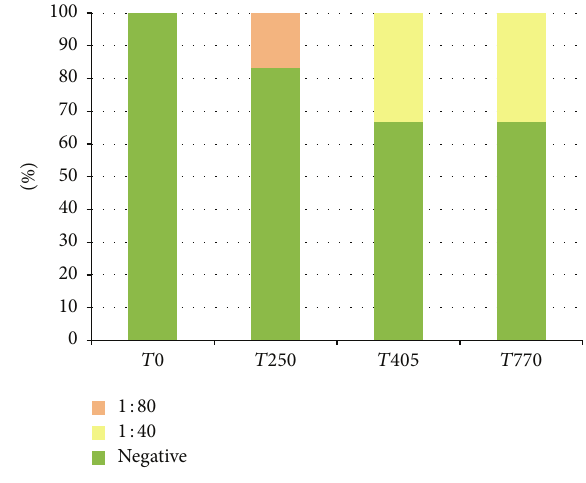
Figure 1: IFAT positivity (%), Group 1.